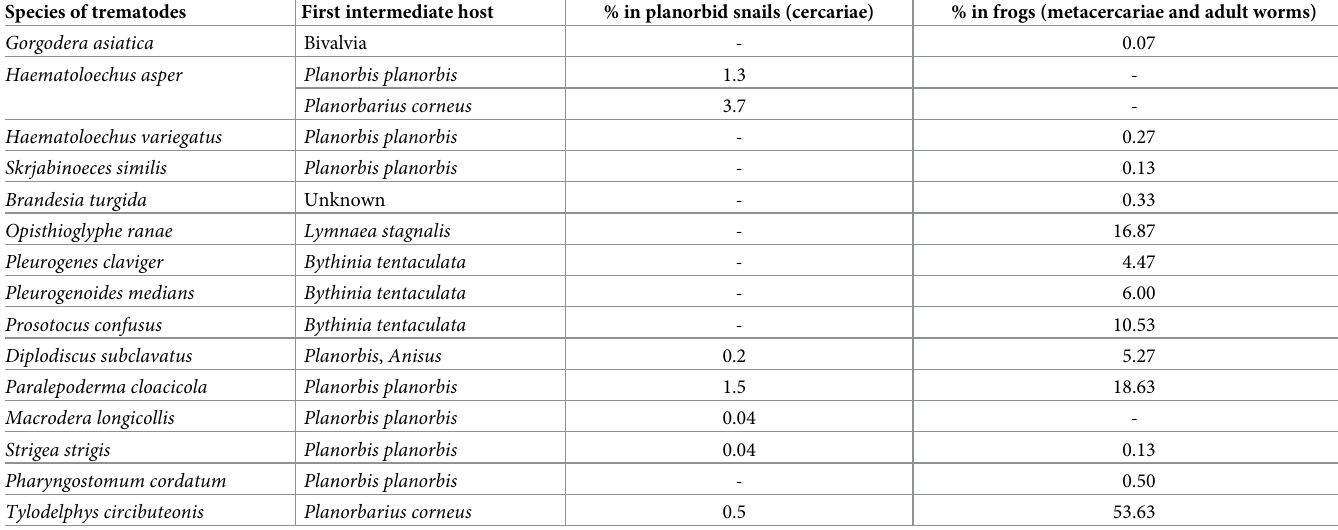
Table 7. Occurrence (%) of trematodes in the first and second intermediate